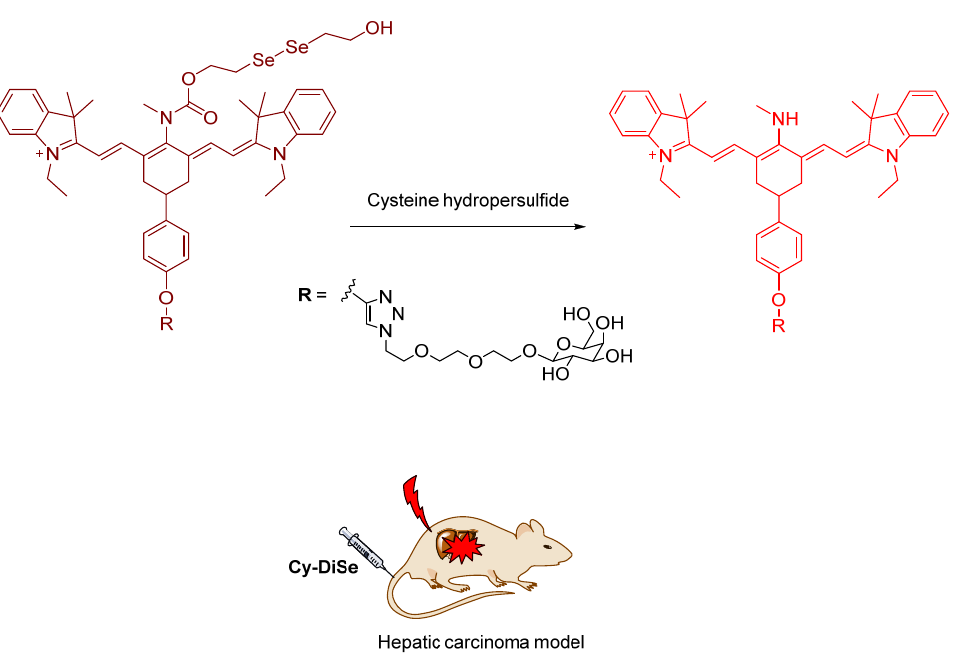
Figure 34. The structure and utility of the Cy – DiSe probe used in analyte detection by Chen et al.